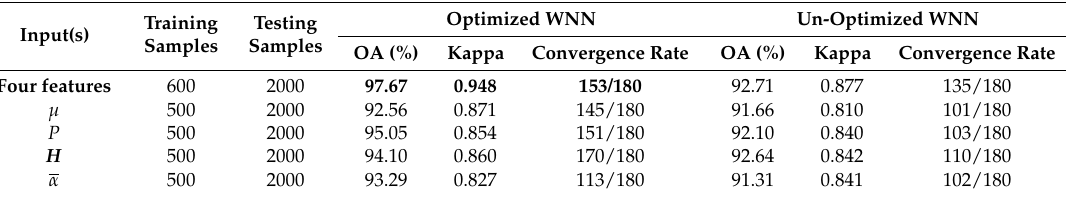
Table 7. The experimental results of Dataset 2.